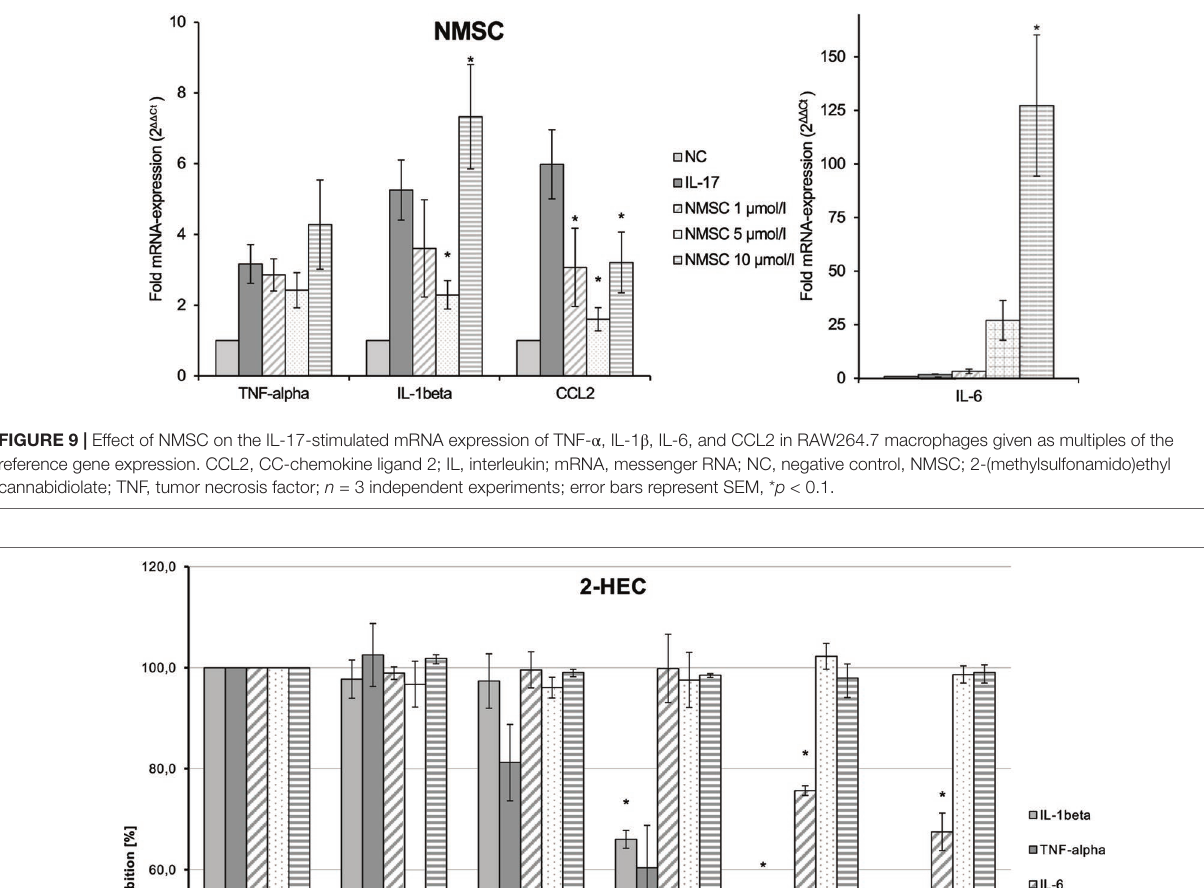
Frontiers in Pharmacology |